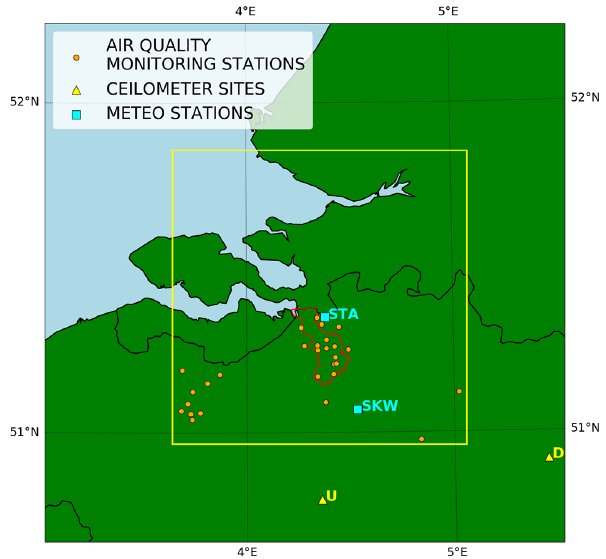
Figure 5. Map showing the geographical location of different in situ data measuring sites. The meteorological (blue square) and air quality (orange circle) sites are in the innermost domain, indicated by the yellow square, while the ceilometer stations (yellow triangle) are in the surrounding area. The red outline represents the Antwerp